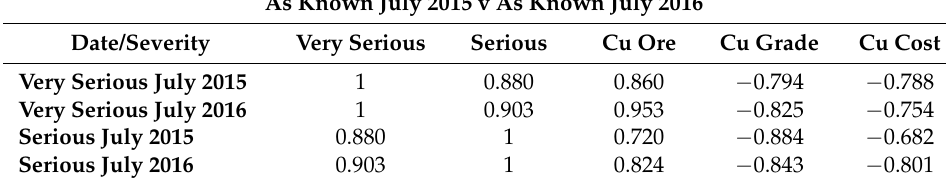
Table 3. Changes in correlations